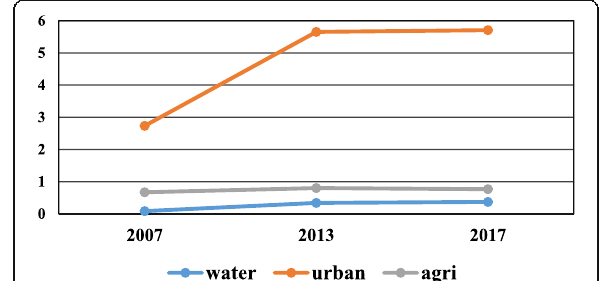
Fig. 13 Diagrams showing temporal changes in different land cover classes in the study area Fig. 14 Lithology of the Quaternary aquifer in the study